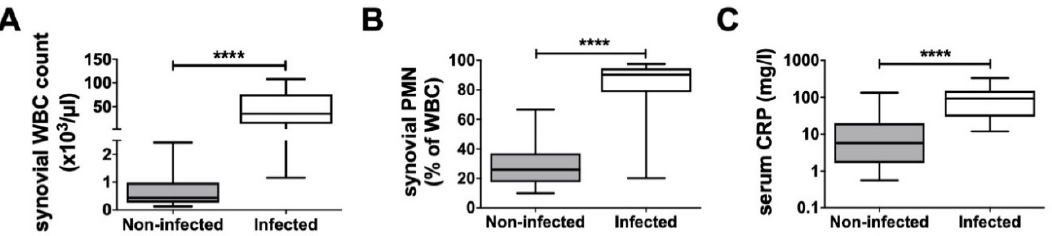
Figure 2. Clinical data for the patient cohort. ( A ) Distribution of synovial leucocytes (non-inf. n = 20, inf. n = 13), ( B ) proportion of neutrophil granulocytes among synovial leucocytes (non-inf. n = 20, inf. n = 13) and ( C ) serum C-reactive protein (CRP) levels (non-inf. n = 30, inf. n = 15) in the non-infected and infected groups. **** p < 0.0001.